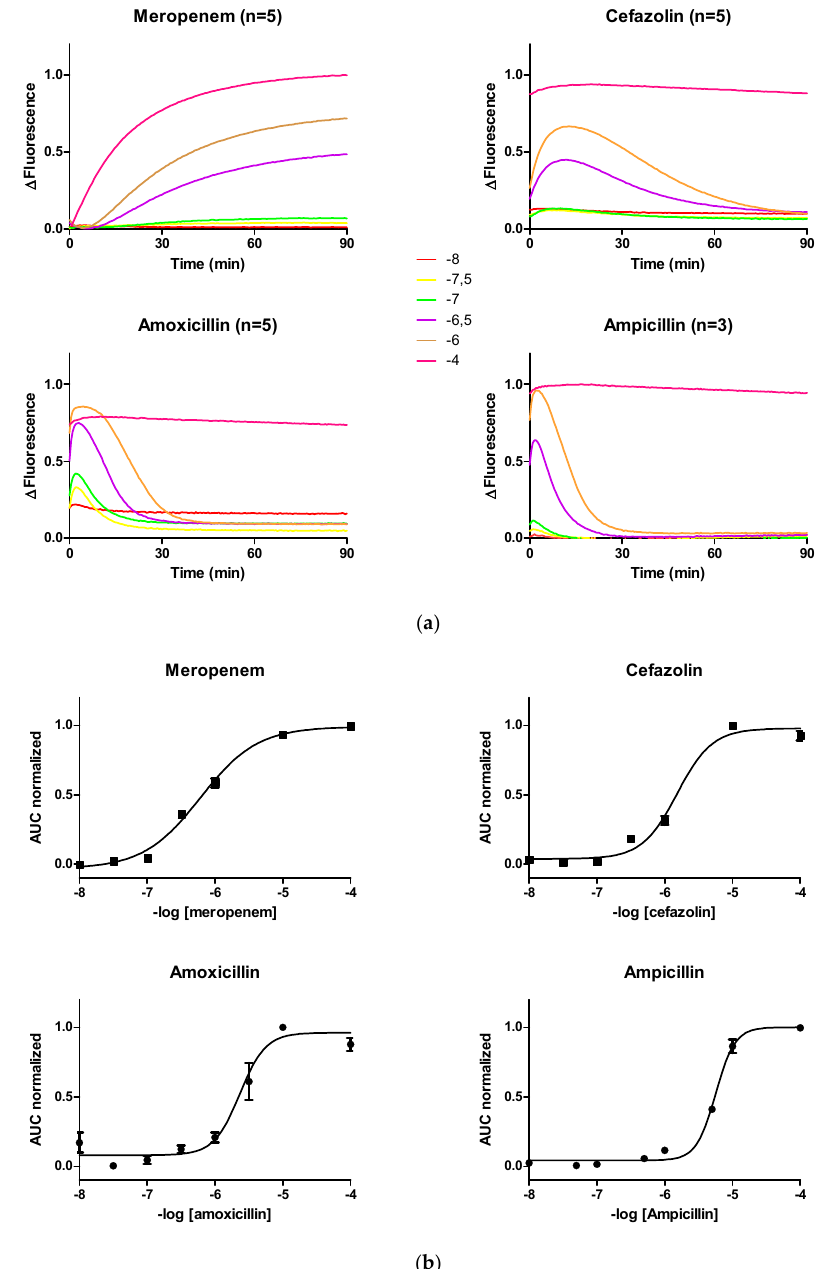
Figure 1. ( a ) The time course of the fluorescence level of PenP induced by different concentrations of meropenem, cefazolin, amoxicillin or ampicillin was recorded. ( b ) For each antibiotic, the area under the normalized fluorescence curve versus the logarithmic concentration of the antibiotic was adjusted to a Boltmzmann curve.